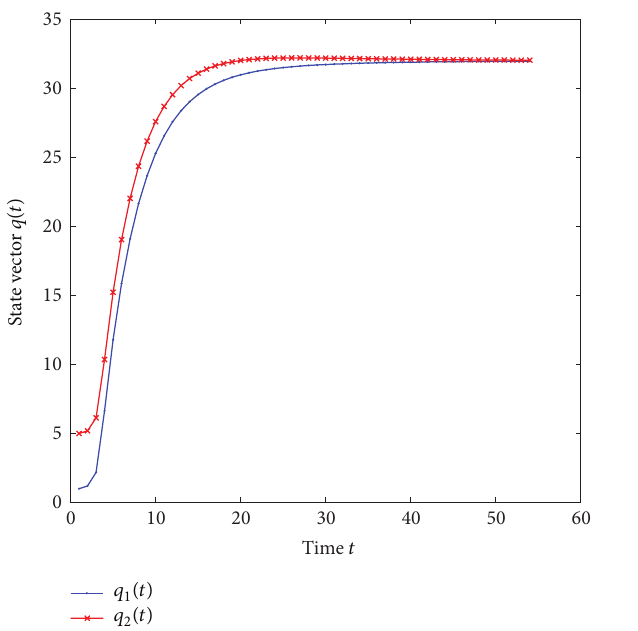
Figure 1: The state vector of system (25) with 𝑞 0 = [1,5] 𝑇 ∈ 𝑋 .